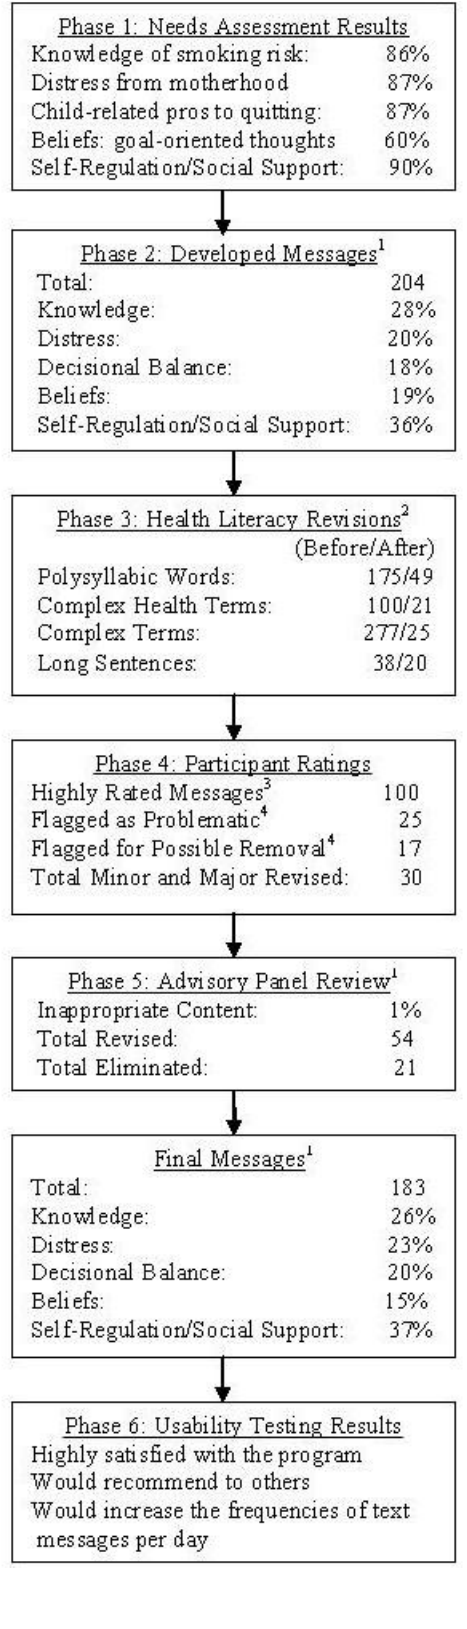
Figure 1. Steps and results from each development phase. 1 Messages may fall under multiple categories; thus, percentages do not sum to 100%. 2 Eleven messages required additional revision to fit within the 159-character limit for text messages. 3 Highly rated messages received a mean rating over 4.5 (out of 5) for “Overall Helpful” and were found to be “Helpful If Stressed” by all raters. 4 Messages were flagged if they received a mean rating less than 4 (out of 5) for “Overall Helpful”; these were then identified for possible removal if two-thirds or more of raters found it “Not Helpful If Stressed,” or designated “Problematic” in all other